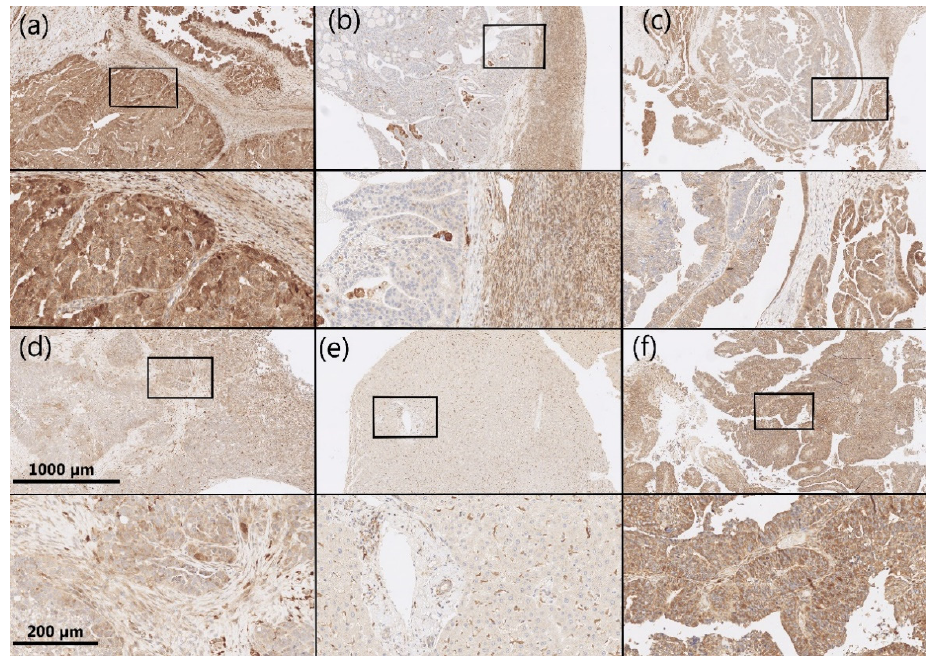
Figure 2. Representative immunohistochemical AKR1B1 staining in HGSC samples and control tissue. ( a – d ) HGSC; ( e ) control liver tissue; ( f ) control endometrioid endometrial cancer. Upper half of panels: 50 × magnification; lower half of panels: the framed area from the upper half of the panel (200 × magnification). AKR1B1: aldo-keto reductase family 1 member B1; HGSC: high-grade serous ovarian cancer.